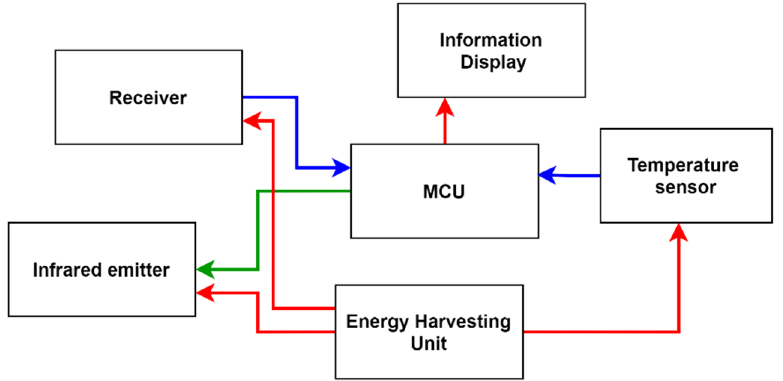
Figure 7. The structure of the prototype LIoT node.